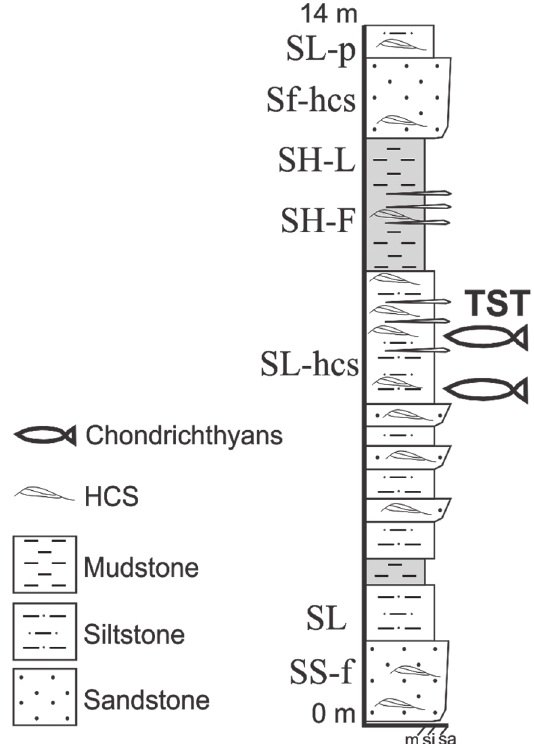
Figure 4 - Composite stratigraphic column based on a series of profiles drawn along the Tibagi-ventania section (see Figure 1) indicating the provenance of the chondrichthyan fin remains (lithostratigraphy based on Bosetti and Horodyski (2008) and Horodyski (2014). TST = Transgressive system tract; HCS = Hummocky